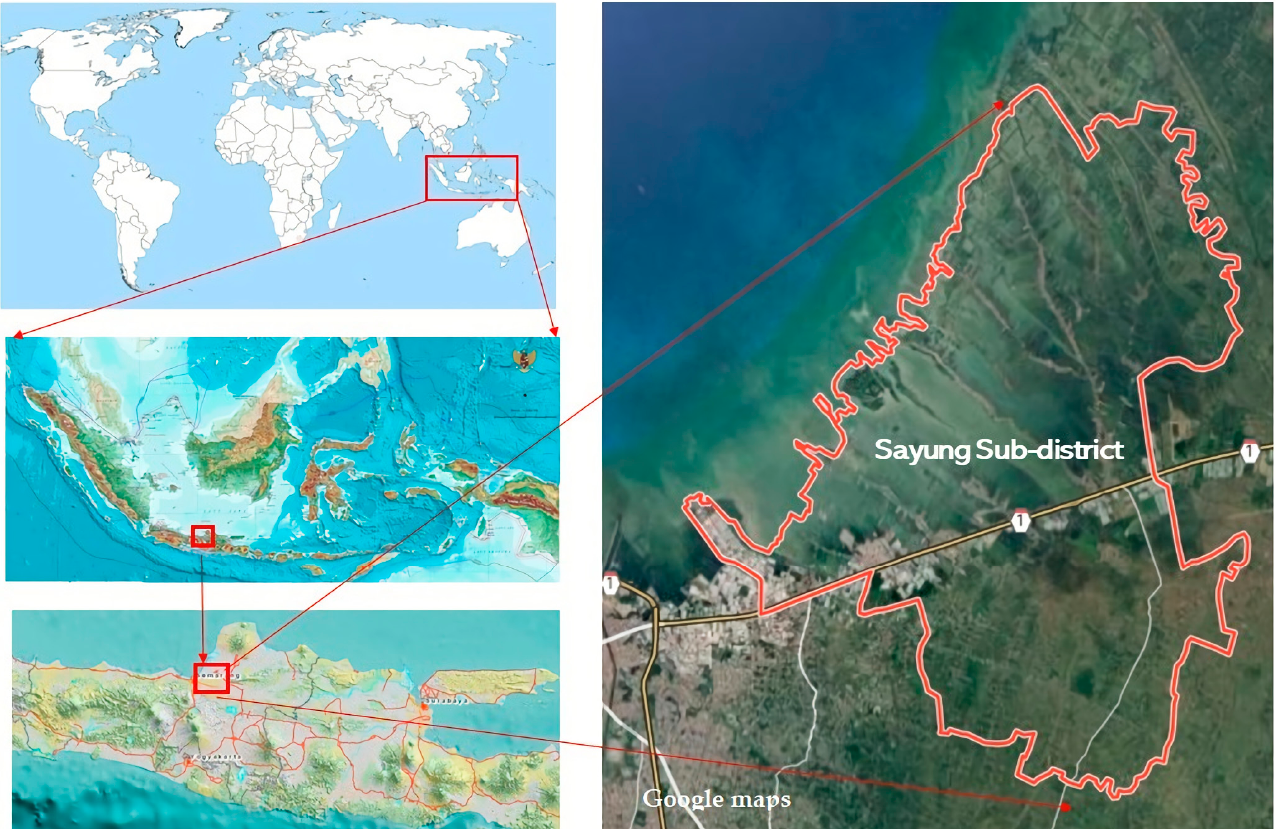
Figure 2. Location of the study area, obtained from Google Maps and Figure 1. Location of the study area, obtained from Google Maps and [26,27].